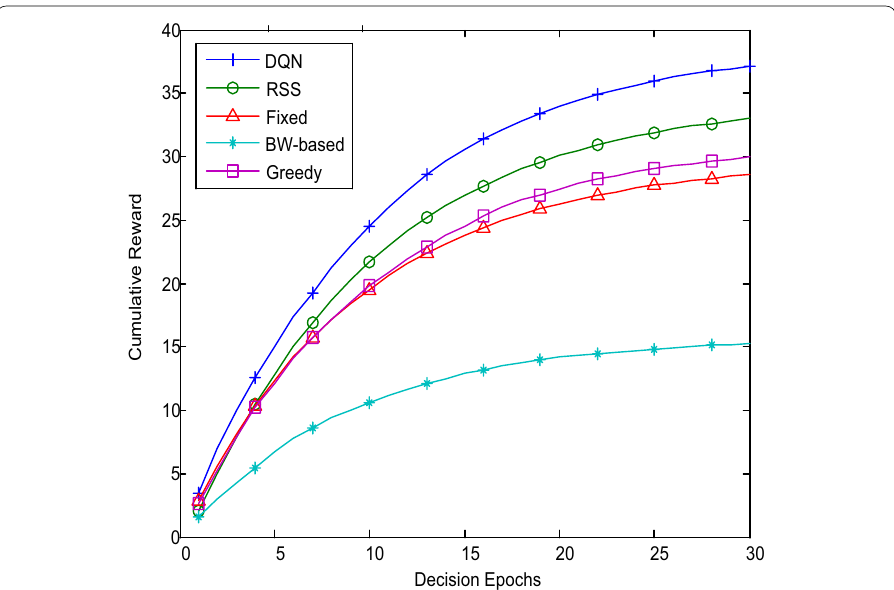
Fig. 4 Cumulative reward. This figure shows the overall cumulative reward of the system as the handoff decision progresses. In the figure, as the number of decision steps increases, the cumulative return of each strategy gradually increases. Among them, the DQN-based handoff algorithm performs better than other algorithms. And as the number of decision steps increases, the advantages of the algorithm become